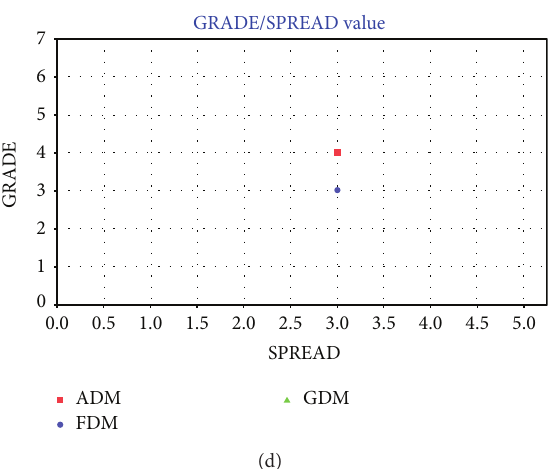
Figure 5: Agreement cases for in-phase responses with 1D FSV tool: (a) ADMi and FDMi, (b) ADMc and FDMc, (c) GDMi and GDMc, and (d) GRADE/SPREAD chart.